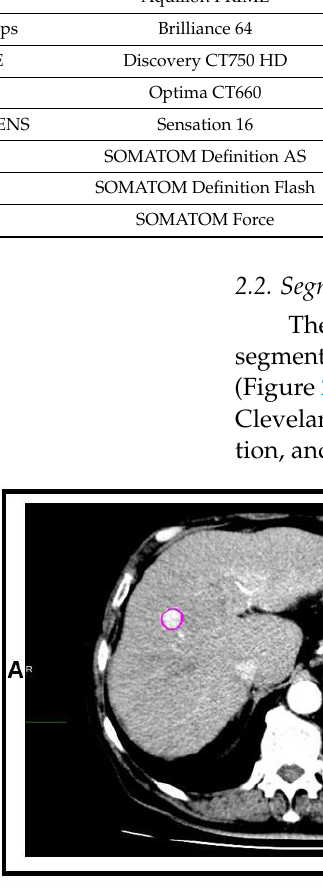
Figure 2. An example of ROI segmented in ( A ) the arterial phase and ( B ) the portal venous phase.